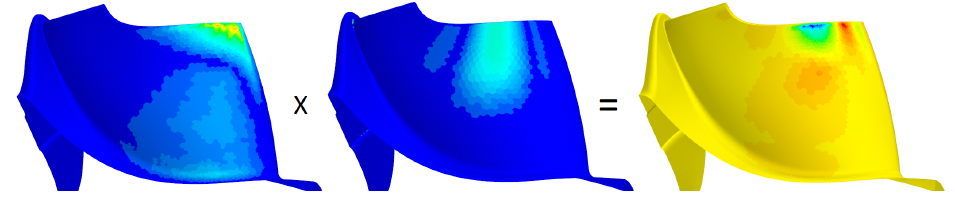
(cid:13) (cid:13) ∂ f e (cid:13) (cid:13) (cid:13) (cid:13) ( left ), design velocity ∂ x